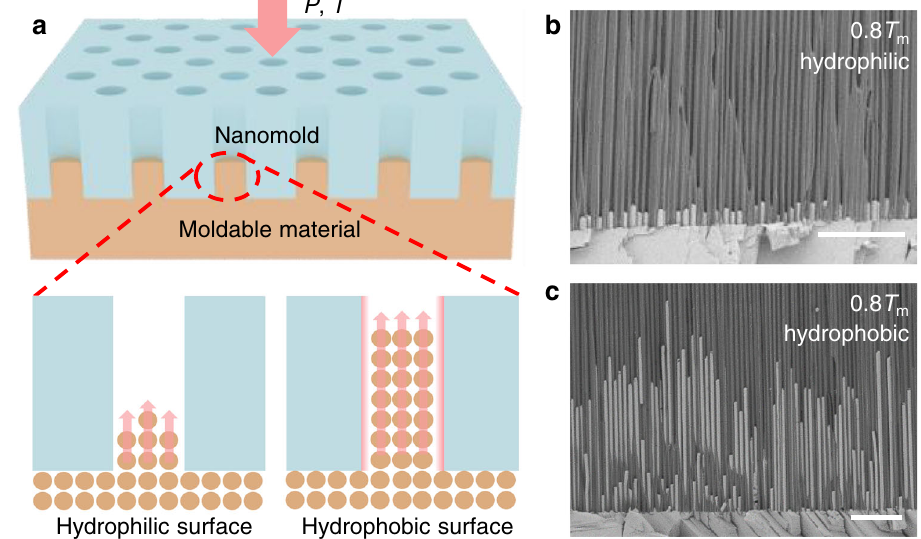
Fig. 1 | Quantifying interface friction by thermomechanical nanomolding (TMNM). a Sketch of typical experimental set-up for studying the effect of surface wettability on interface friction. b – c SEM image of Bi nanowires prepared by